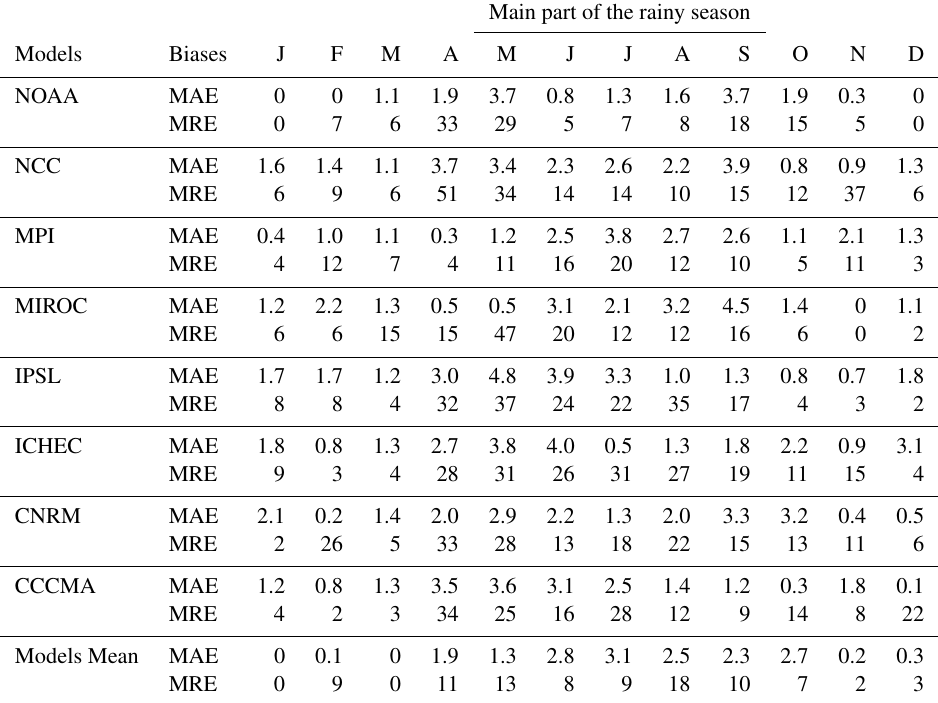
Table 3. Spatial mean Rainfall MAE (in mm) and MRE (in %) between observations and bias corrected simulations over Mono river basin. Main part of the rainy season Models